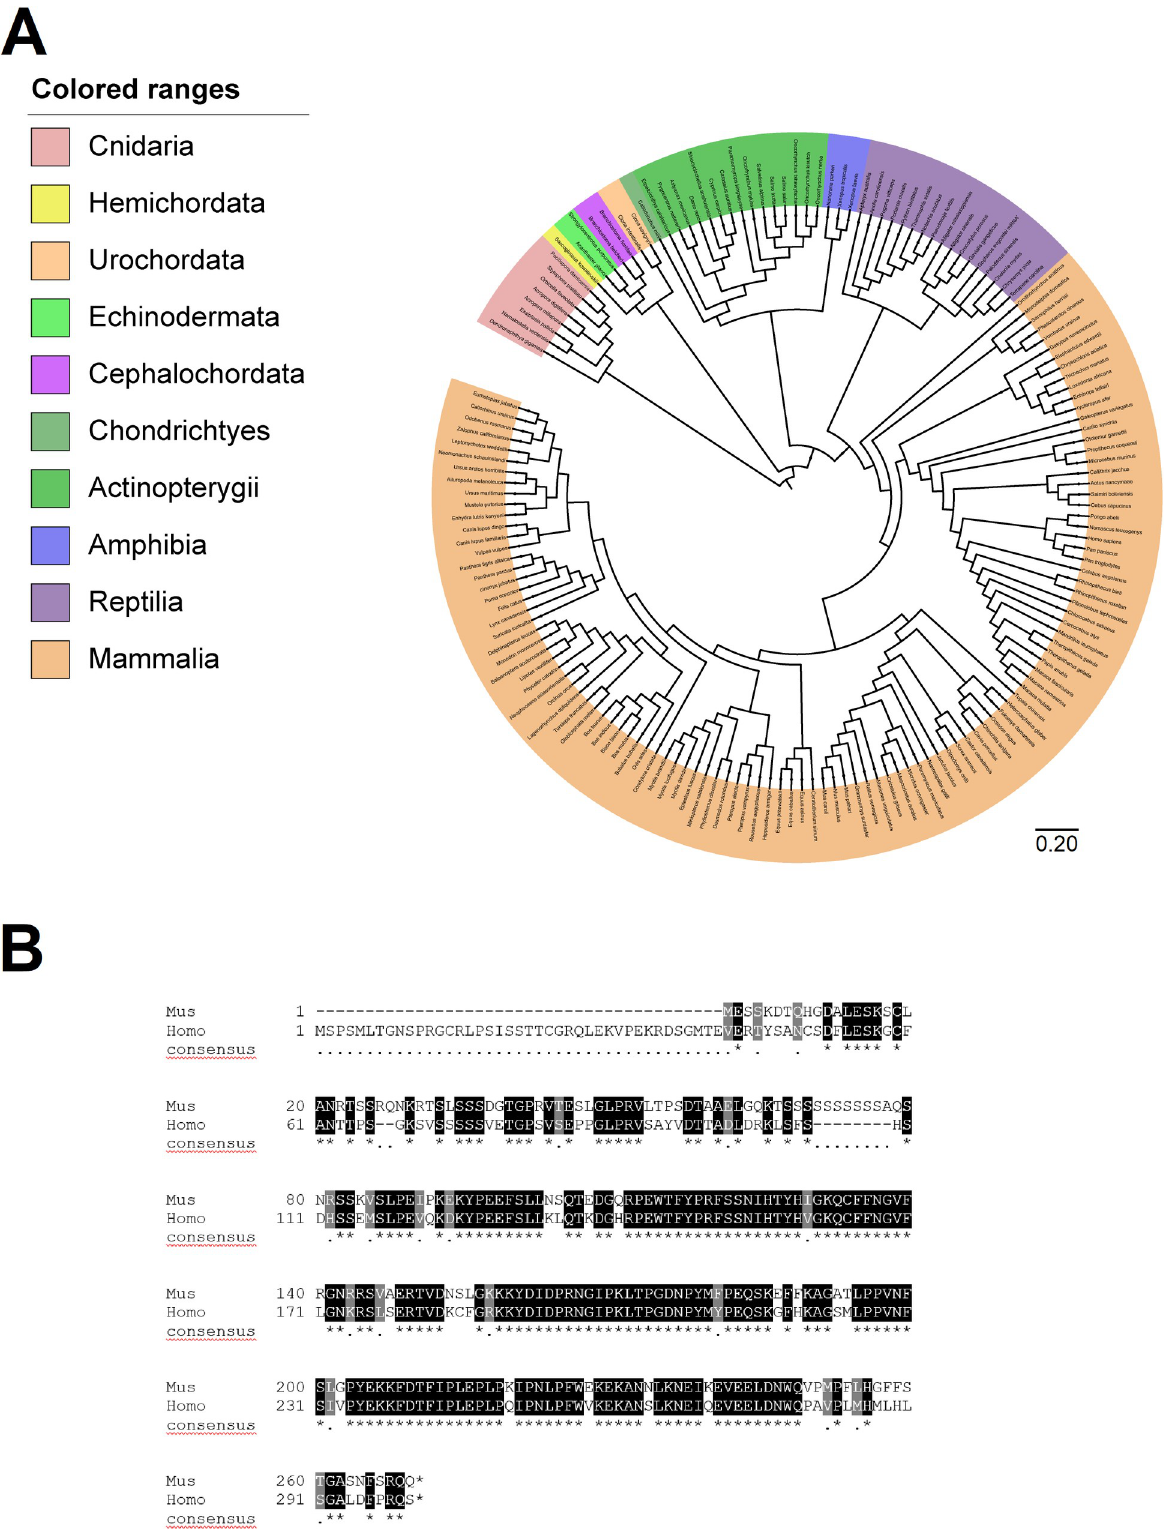
Fig 1. Conservation of SPATS1 in metazoans. (A) Highly resolved tree showing the presence of SPATS1 and its phylogenetic relationship across different metazoans taxa. The tree is drawn to scale, with branch lengths measured in the number of substitutions per site. (B) Alignment of